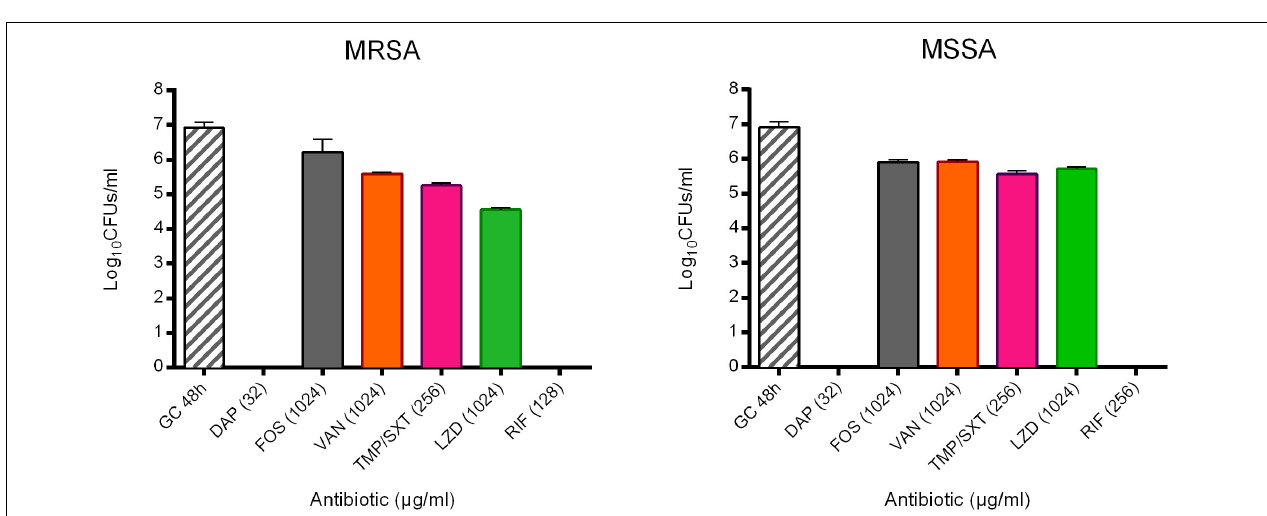
FIGURE 3 | Evaluation of the anti-biofilm activity of the highest tested concentrations ( µ g/ml) of daptomycin (DAP), fosfomycin (FOS), vancomycin (VAN), trimethoprim/sulfamethoxazole (TMP/SXT), linezolid (LZD) and rifampicin (RIF) against biofilm of either MRSA or MSSA by sonication and colony counting